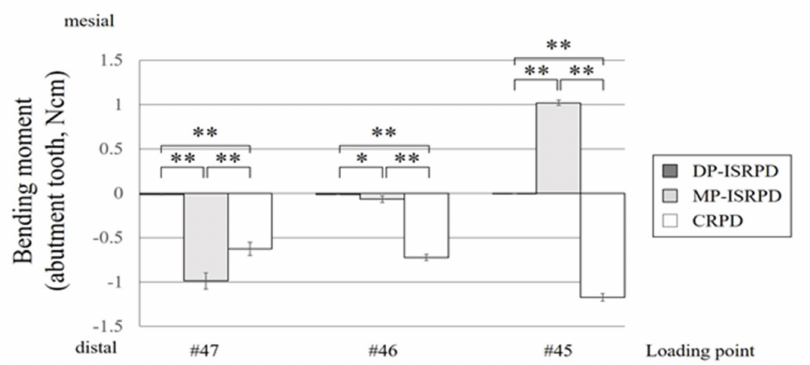
Figure 6. Bending moment (Ncm) of abutment tooth under each loading point (#45, #46 and #47) in conventional removable partial denture (CRPD), mesially positioned implant-supported removable partial denture (MP-ISRPD) and distally positioned implant-supported removable partial denture (DP- ISRPD). Error bars represent the standard deviation, and statistical analyses are described as * p < 0.05 and ** p < 0.01, analysis of variance (ANOVA) with Tukey Honestly Significant Difference (HSD).